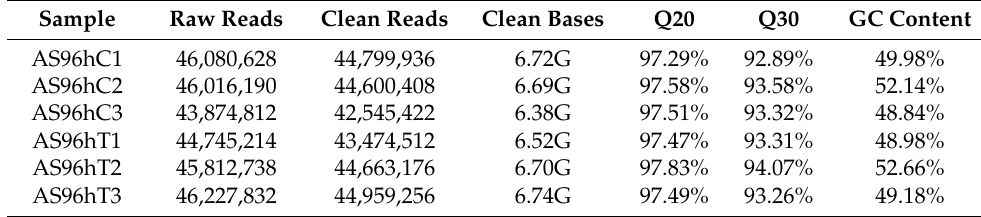
Table 1. Overview of RNA sequencing data in this